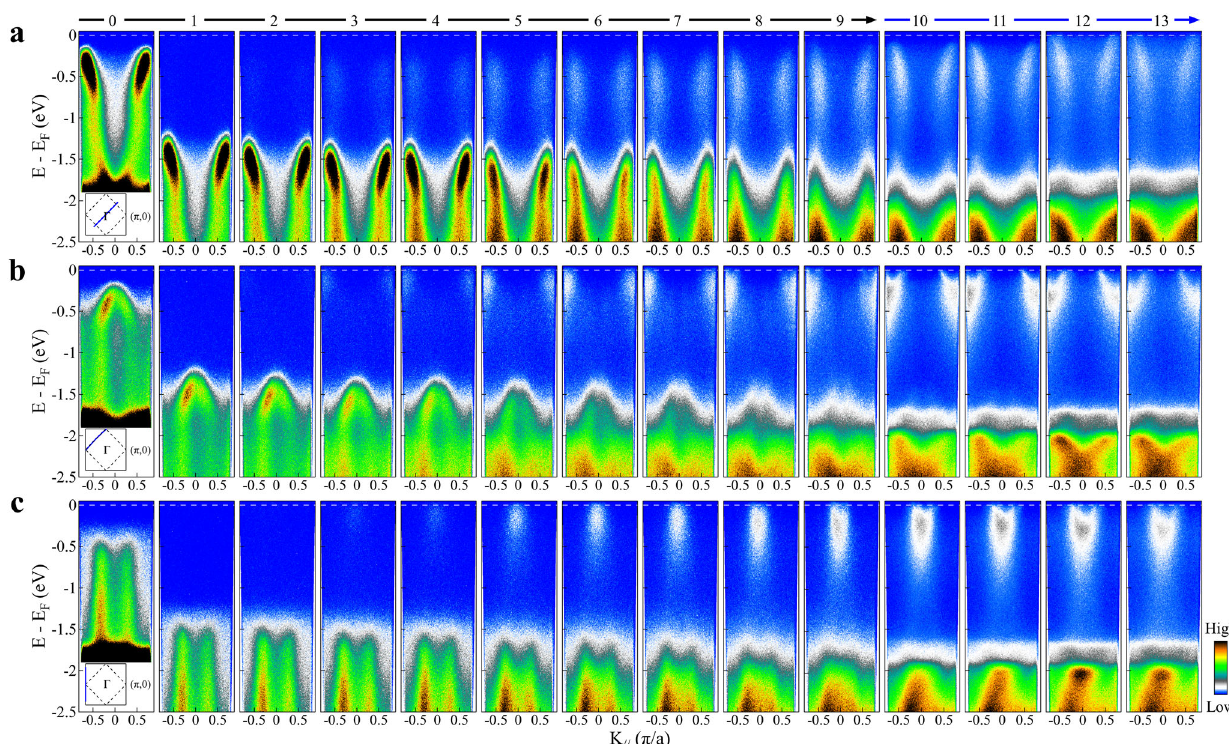
Fig. 2 Band structure evolution of Ca 3 Cu 2 O 4 Cl 2 with Rb deposition. a Doping evolution of band structure along with the ( − π /2, − π /2) – ( π /2, π /2) nodal momentum cut. b Band structure evolution with Rb deposition along the ( − π , 0) – (0, π ) momentum cut. c Band structure evolution with Rb deposition along with the ( − π , − π ) – ( − π , π ) cut. The locations of the three momentum cuts are illustrated by the blue solid line in the inset of panels ( a ), ( b ), and ( c ),